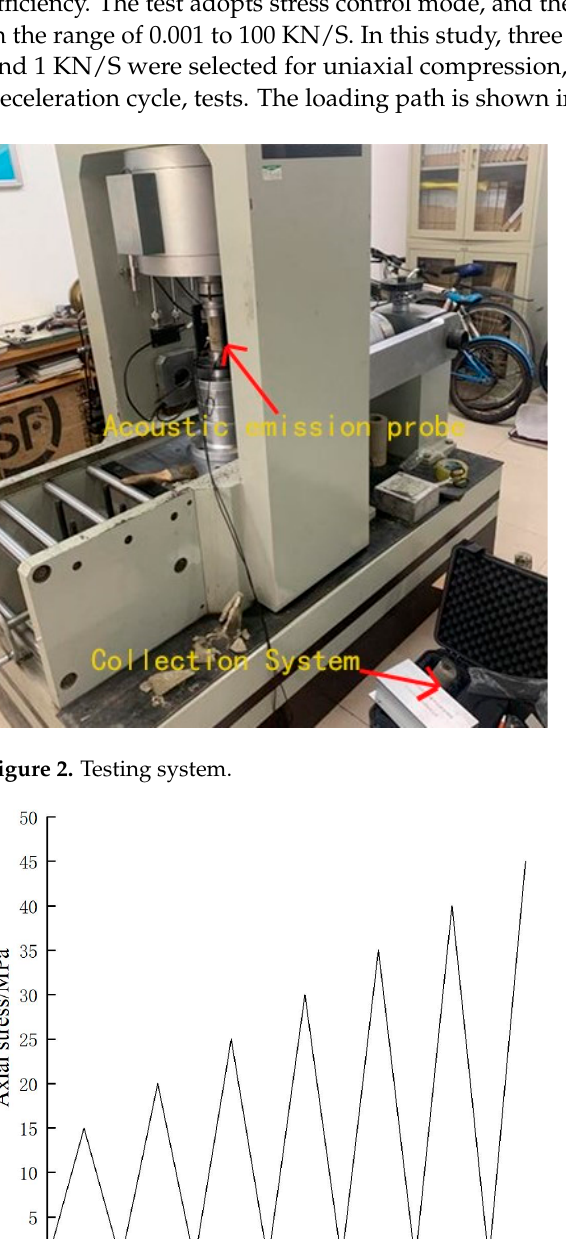
Figure 3. Schematic diagram of loading path.